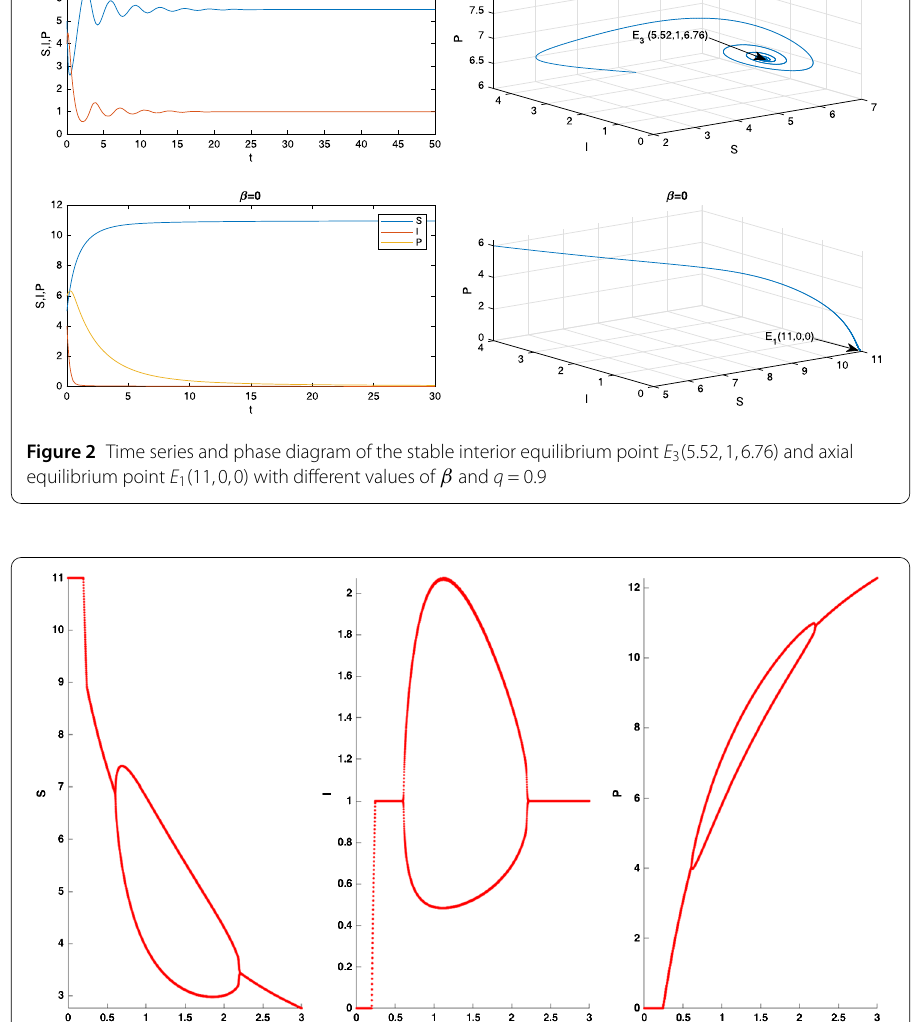
in Fig. 2(b) concurring with Fig. 5. Therefore, the prey’s disease ( β ) has a crucial role in population dynamics and may make the dynamics stable between